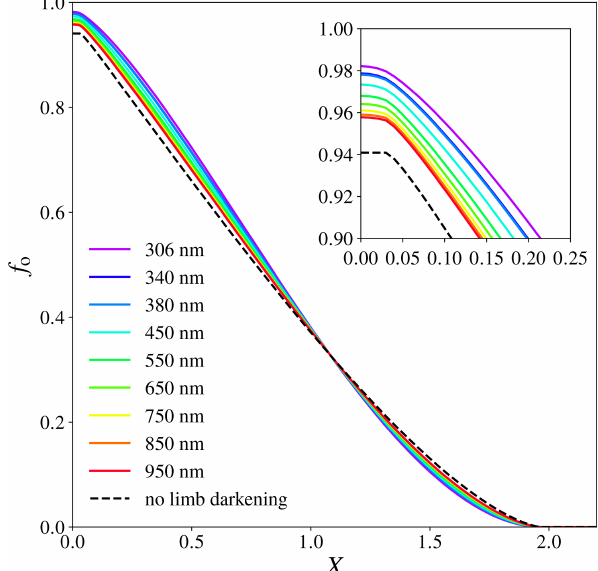
Figure 7. The obscuration fraction f o as a function of Moon–Sun disc centre distance normalized to the solar disc radius, X , for wave- lengths ranging from 306 to 950nm, using the limb darkening coef- ficients of Pierce and Slaughter (1977) and Pierce et al. (1977). The dashed line is the result without solar limb darkening taken into ac- count ( (cid:48) = 1). The assumed value for r m is 0.97, corresponding to the instant of greatest eclipse during the annular solar eclipse on 26 December